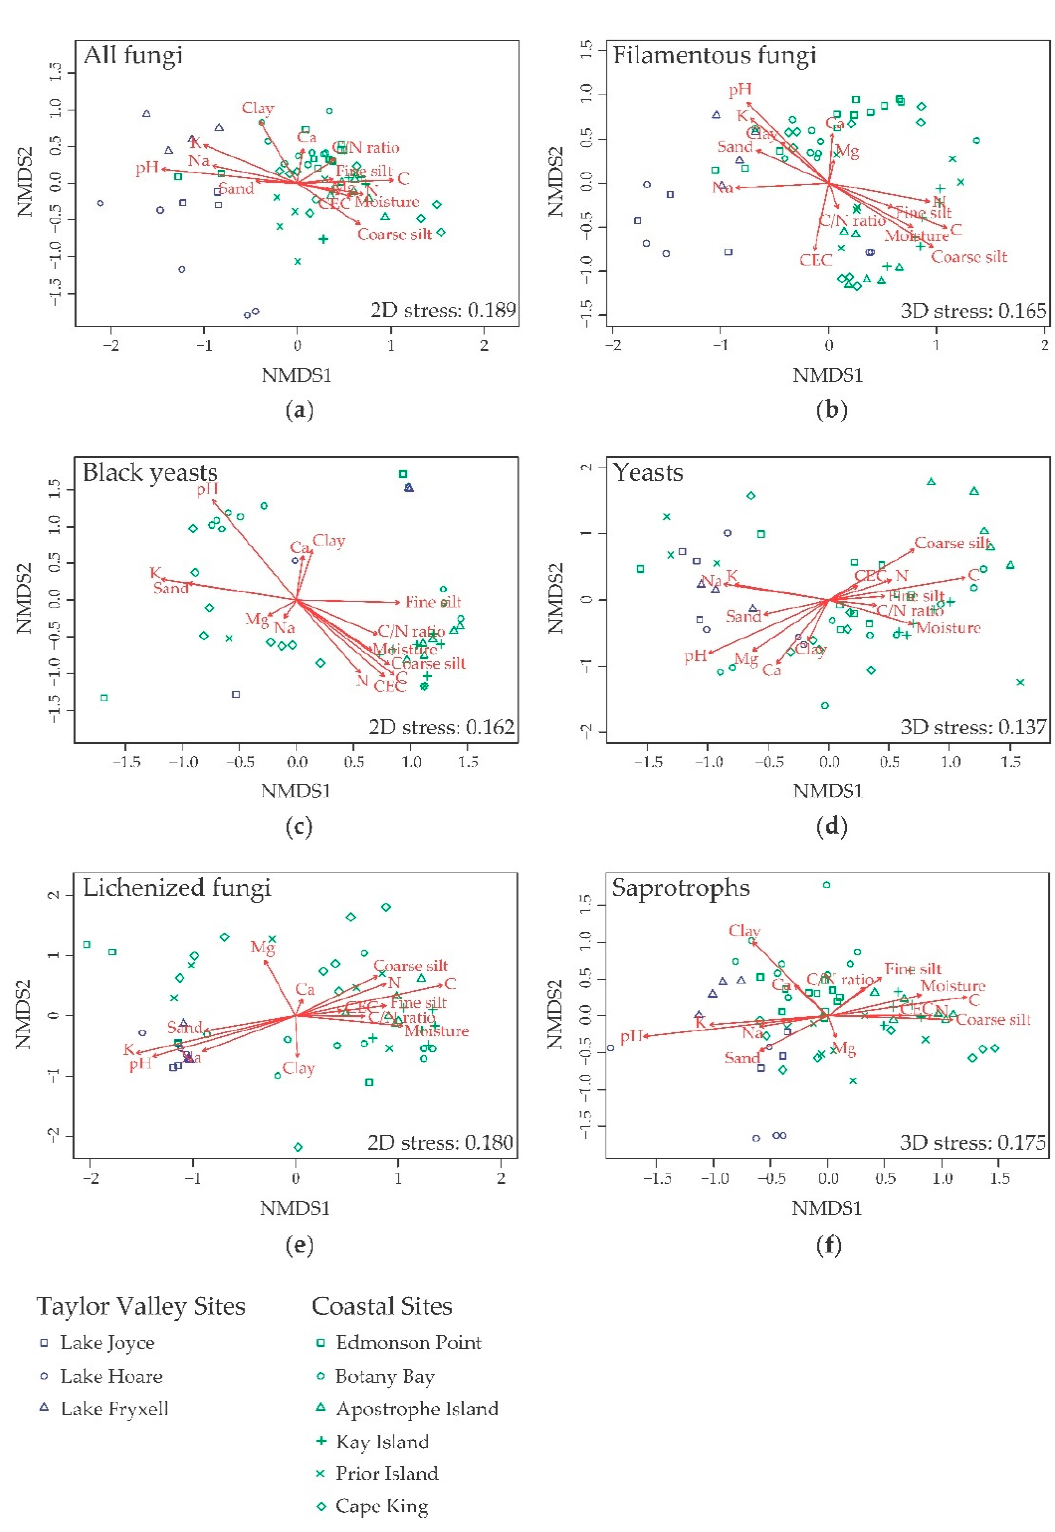
Figure 6. Nonmetric multidimensional scaling (NMDS) ordinations of the differences (Bray–Curtis distance) in fungal community composition (Hellinger transformed operational taxonomic units (OTUs) abundances) in the two different environments (Taylor Valley: Blue; coastal sites: Green) and different localities (different symbols). The different panels report ordinations for the total fungal community ( a ), the different growth forms categories ( b – d ), and functional guilds ( e , f ). The significance and the strength of the correlation of all the variables in the figure are reported in Table